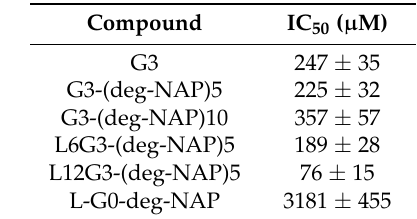
Table 4. The effect of G3-naproxen conjugates (LyG3-(deg-NAP)x) and L-G0-deg-NAP on the viability of Caco-2 cells as determined by IC 50 (mean ± S.D., n = 4).